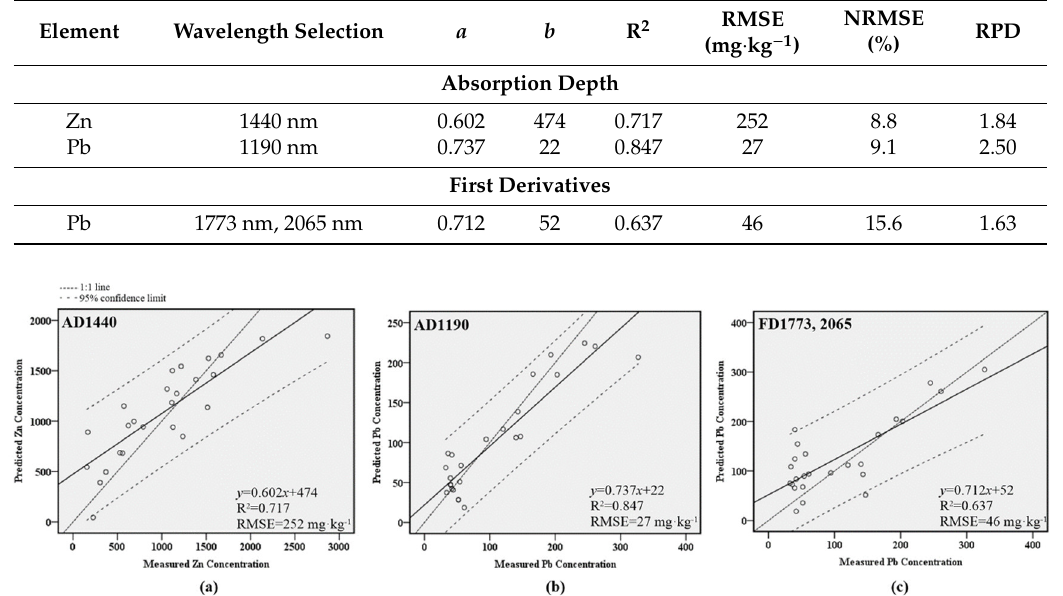
Figure 9. Comparison between the measured heavy metal concentration in experiments and predicted heavy metal concentration derived from regression models of Group B. ( a ) Validation model at absorption depth of 1440 nm for Zn concentration; ( b ) validation model at absorption depth of 1190 nm for Pb concentration; ( c ) validation model at first derivatives of 1773, 2065 nm for Pb concentration.